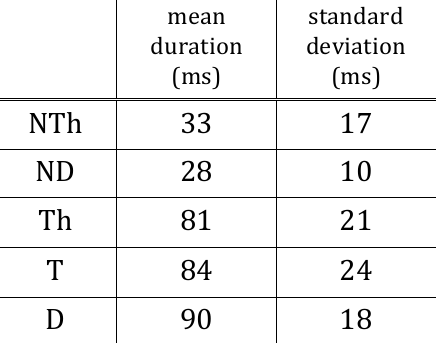
Table 5: Comparison of closure duration across plosives